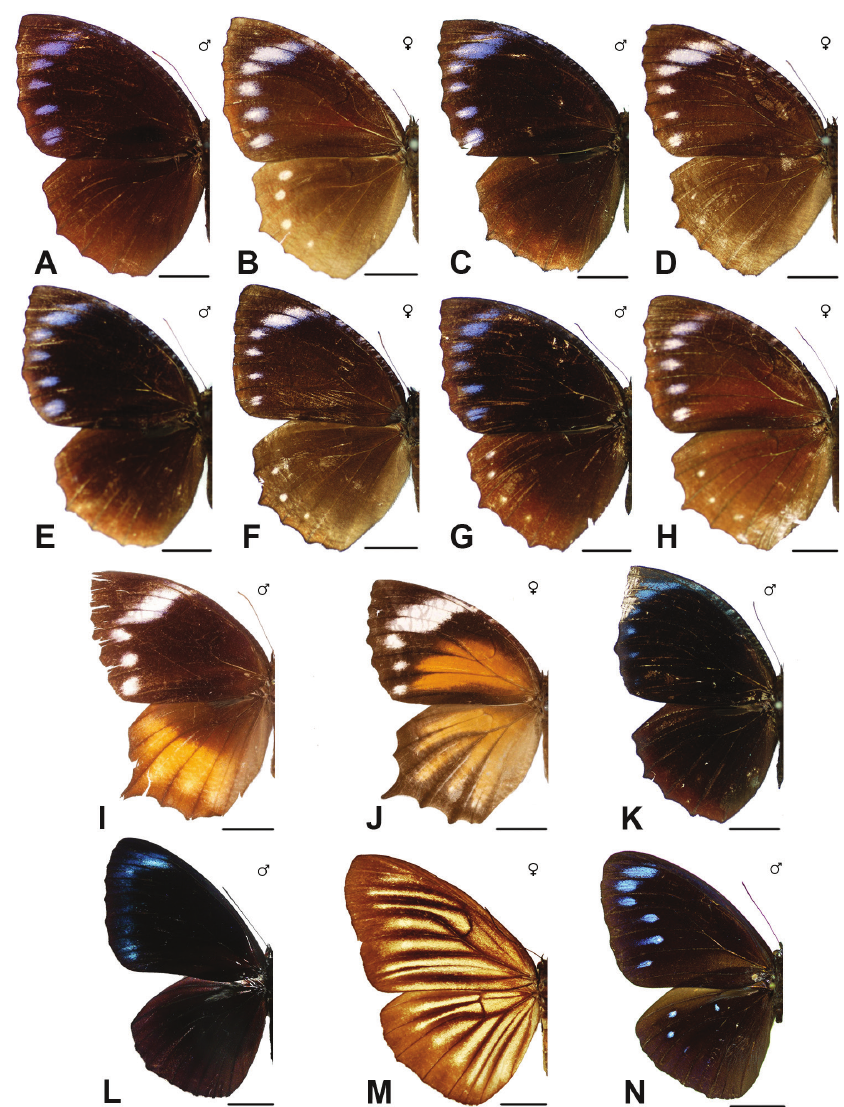
Figure 8. A hypermnestra sumbawana ♂ D NHM Indonesia: West Nusa Tenggara, Sumbawa B hyperm- nestra sumbawana ♀ D NHM Indonesia: West Nusa Tenggara, Sumbawa C hypermnestra timorensis ♂ D NHM East Timor: Dili D hypermnestra timorensis ♀ D NHM East Timor: Dili E hypermnestra alorensis ♂ D NHM Indonesia: East Nusa Tenggara, Adonara F hypermnestra alorensis ♀ D NHM Indonesia: East Nusa Tenggara, Adonara G hypermnestra uemurai ♂ D NHM Indonesia: West Nusa Tenggara, Lombok H hypermnestra uemurai ♀ D NHM Indonesia: West Nusa Tenggara, Lombok I caudata ♂ D NHM Myanmar (specimen is likely mislabeled) J caudata ♀ D NHM India: Kerala, Malabar K merula ♂ D NHM Sri Lanka: Central Province, Kandy; Holotype L nepheronides nepheronides ♂ D HSPC Indonesia: East Nusa Tenggara, Flores M nepheronides nepheronides ♀ D NHM Indonesia: East Nusa Tenggara, Flores N nepheronides tamborana ♂ D OPC Indonesia: Sumbawa, Mt. Sengenges; Holotype